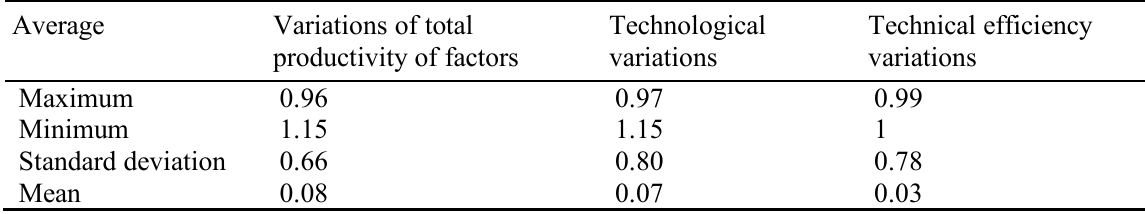
Technological Technical efficiency variations variations